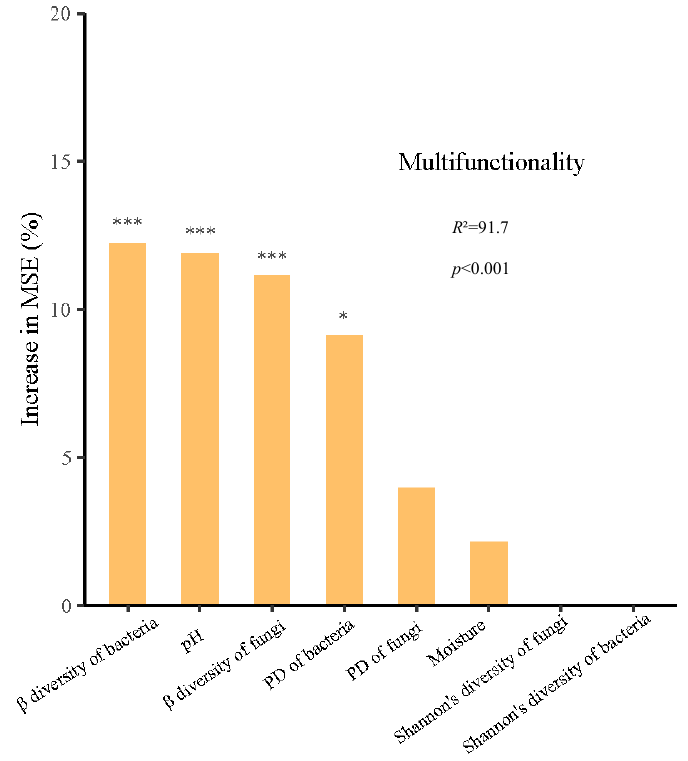
Figure 6. The contribution of bacterial and fungi Shannon indexes, phylogenetic diversities (PD), and communities compositions ( β diversity) to the prediction to soil EMF. MSE is the mean square error. The different lowercase letters above the bars denoted significant differences ( p ＜ 0.05).